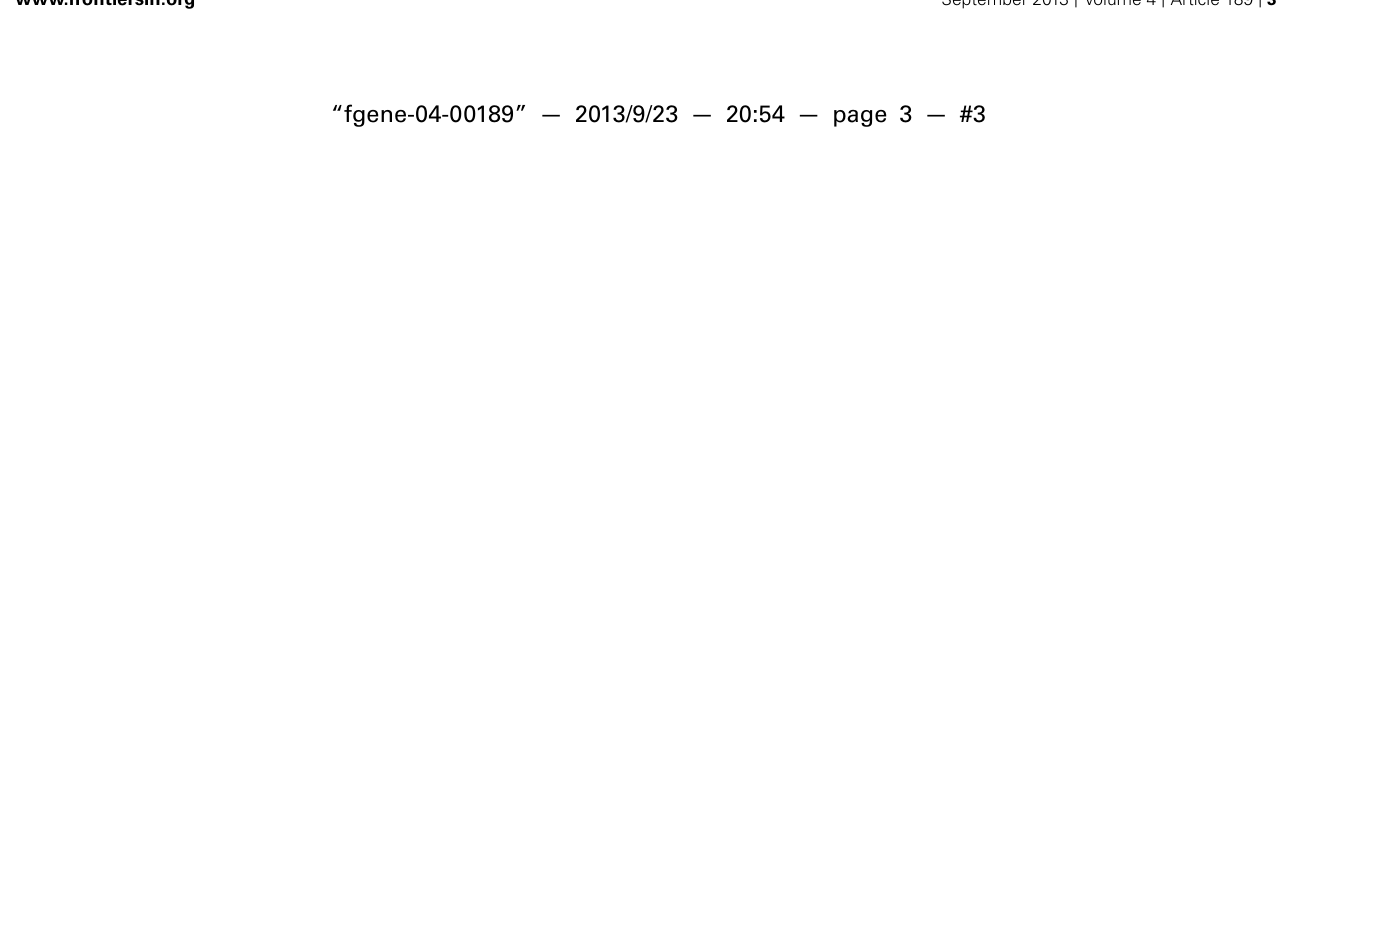
similarity coefficients, visualization of genetic similarity coefficients, and the variance-covariance matrix of coefficients of IBD.The tools denoted by dotted lines are anticipated future